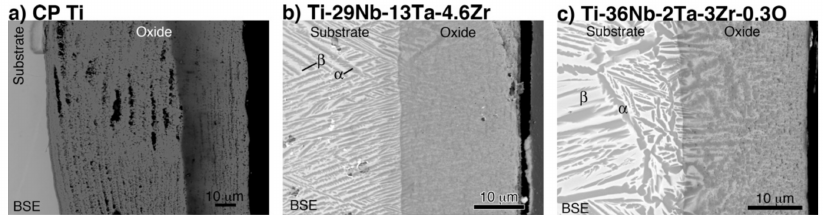
Figure 7. Back-scattered electron (BSE) images of the interfacial microstructure of oxidized ( a ) CP Ti, ( b ) Ti–29Nb–13Ta–4.6Zr, and ( c ) Ti–36Nb–2Ta–3Zr–0.3O. The oxidation conditions at 1273 K for 1.8 ks in air.